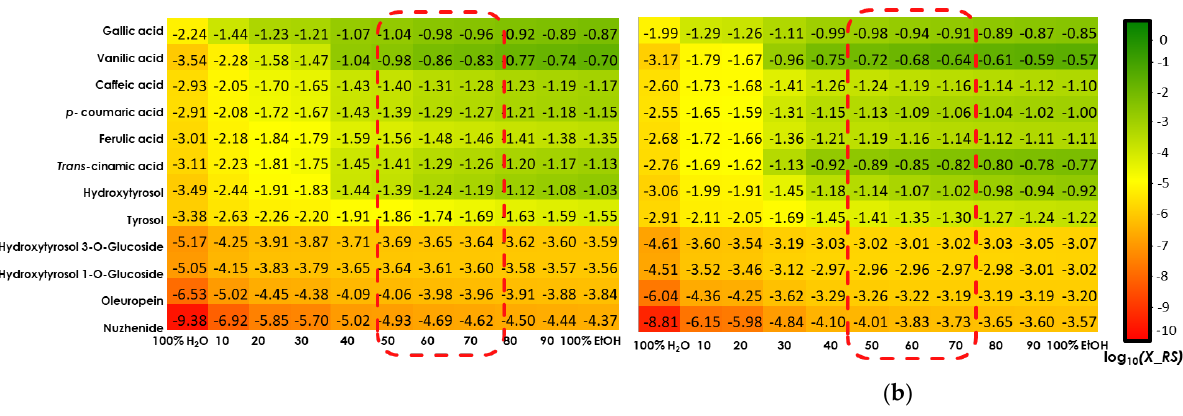
Figure 3. COSMO-RS solubility prediction at 20 °C ( a ) and at 50 °C ( b ) with several ratios of EtOH/H 2 O. Green color: high probability of solubility ( ≥ 60%). Yellow color: medium probability of solubility (20 – 60%). Red color: low probability of solubility (<20%). It can be clearly observed that all six acids, as well as 3- hydroxytyrosol and tyrosol, have a high solubility index to the ratio 50:50 ethanol/water for both temperatures. Gallic acid also shows high solubility for EtOH/H 2 O ratios (40:60, 30:70 and 20:80), and vanillic acid and trans -cinnamic acid for EtOH/H 2 O ratios (40:60 and 30:70). On the other hand, both glycosidic forms of hydroxytyrosol present a medium solubility index in the refer- ence solvent and it decreases through the solvent system to have mostly a low solubility in 100% water. Nuzhenide followed by Oleuropein shows the lowest solubility values DOP at 20 ◦ C and 4.76 ± 0.13 mg TE/g DOP at 50 ◦ C after 20 min of maceration. even in 100% EtOH, as indicated by its medium solubility index.